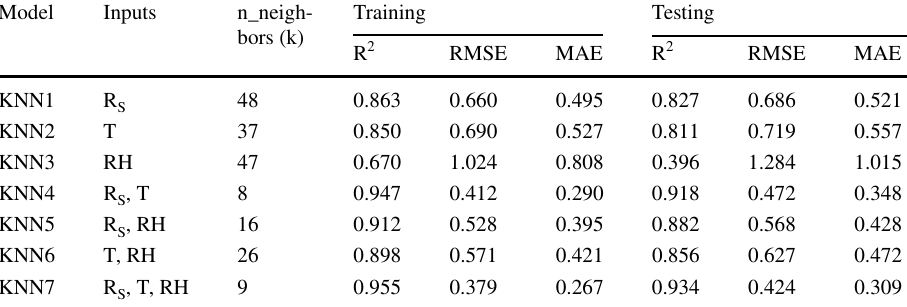
Fig. 3 Pearson correlation analysis of the selected variables Table 2 Performance criteria obtained from the KNN models